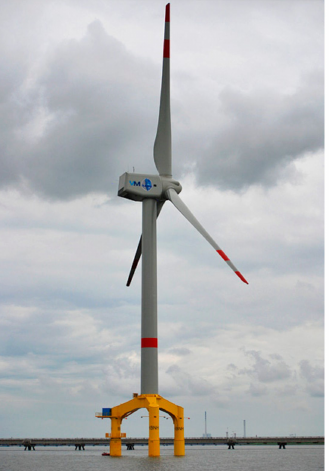
Figure 7. Bard 5 MW wind turbine over a tripile